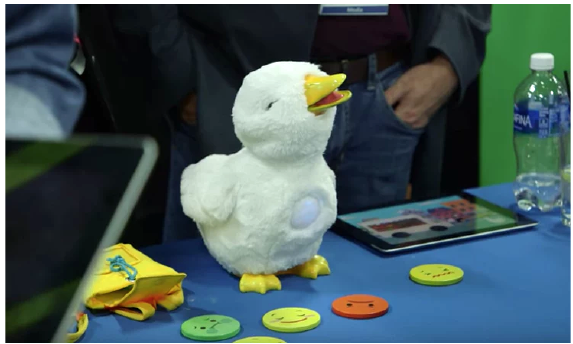
Figure 4. Aflac Duck